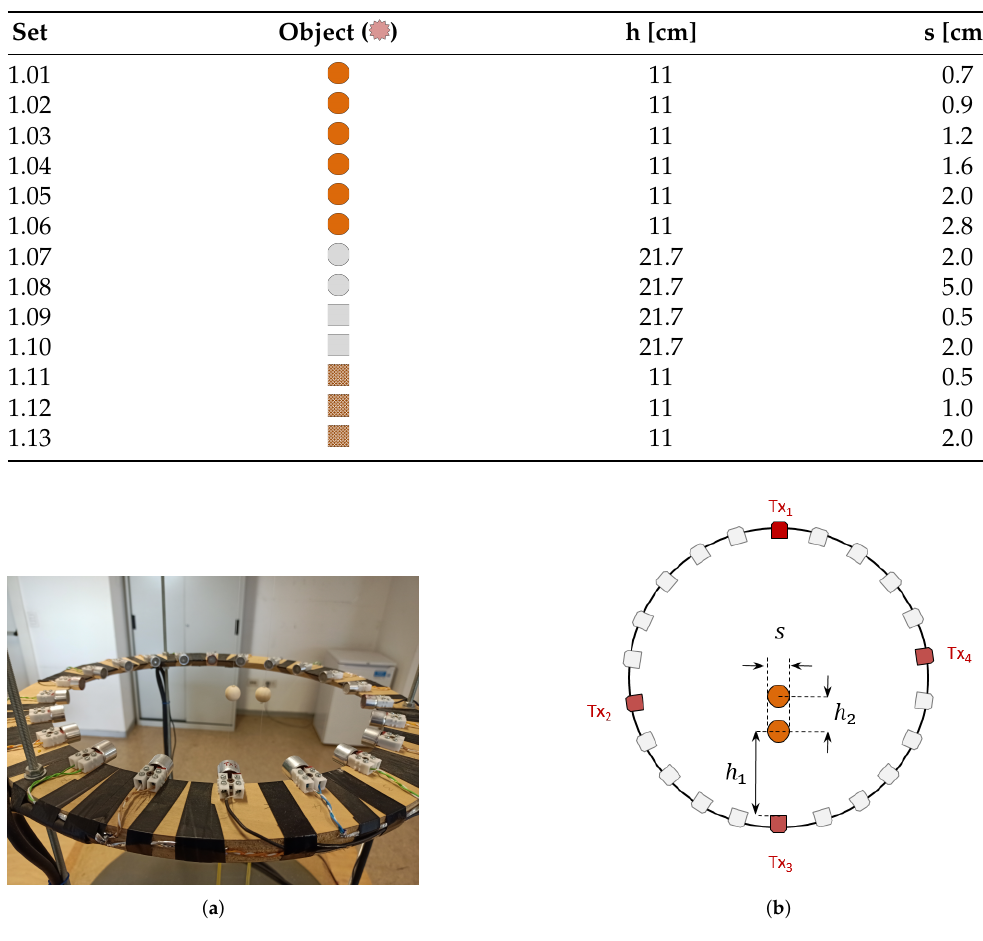
Figure 6. Scenario 2: two wooden spheres of equal size. ( a ) Picture of an acquisition and ( b ) its sketch in a two-dimensional